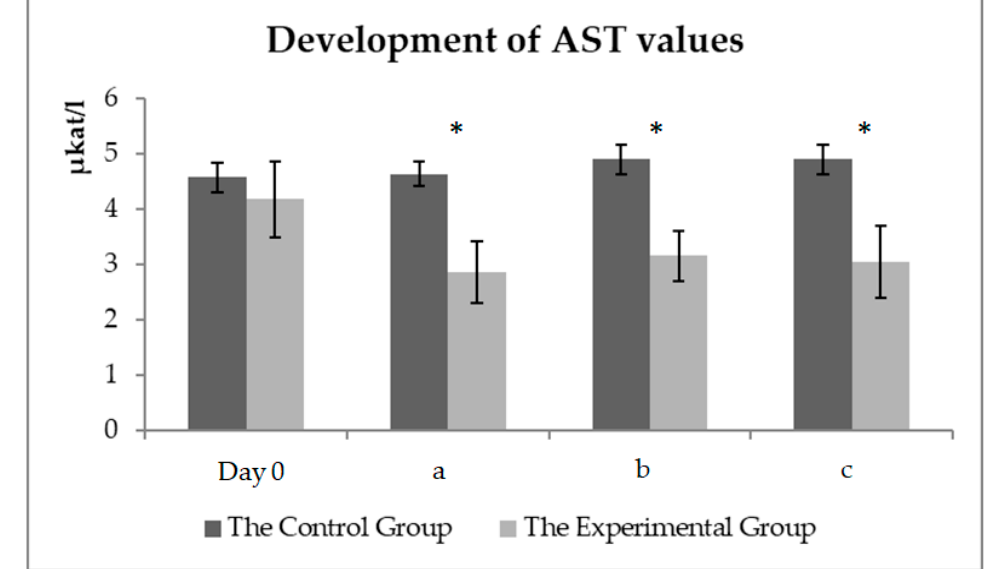
Figure 4. The AST values (µkat/L) in the control and experimental groups. Day zero values before the beginning of the experimental monitoring (day zero)—sample one; ( a ) the values before the start of the training (day 56)—sample two; ( b ) the values about 15 min after the end of the training (day 56)—sample three; ( c ) the values about 60 min after the end of the training (day 56)—sample four. * symbol indicates a significant difference between the control and experimental groups at the level of p < 0.05.